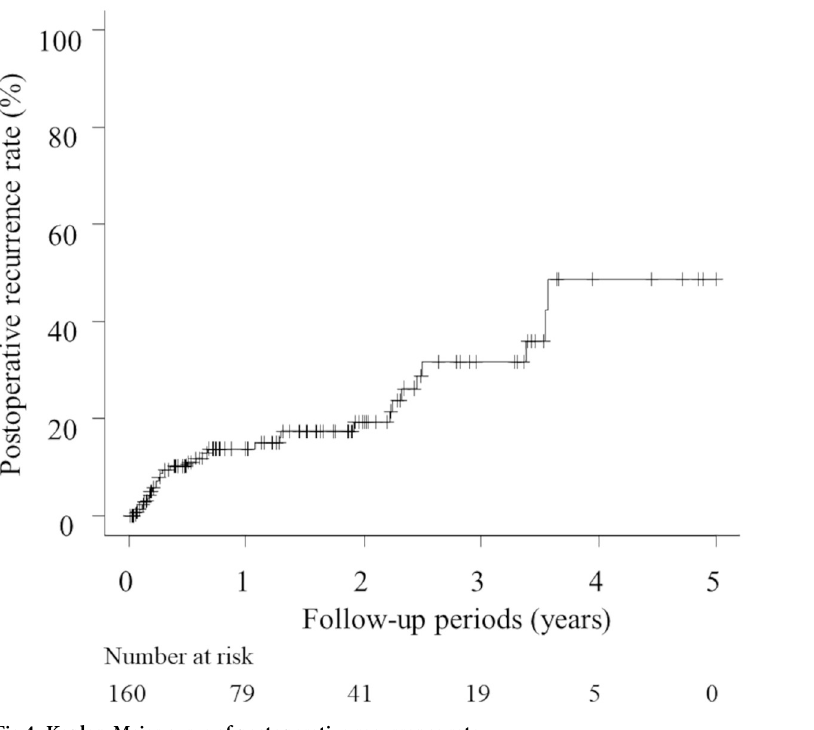
Fig 4. Kaplan-Meier curve of postoperative recurrence